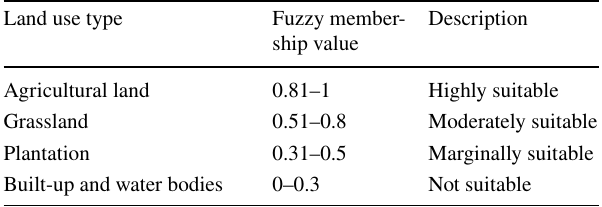
Table 3 Criteria for the classification of land use Land use